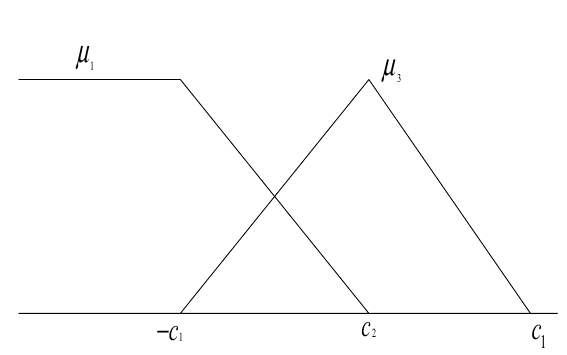
Fig. 20 Membership function of sample output